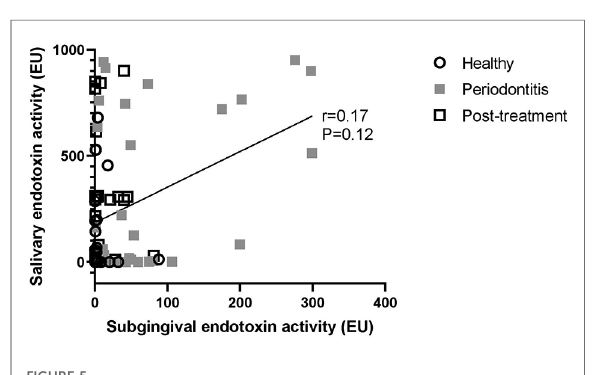
FIGURE 5 No correlation between subgingival and salivary endotoxin activity levels was detected.